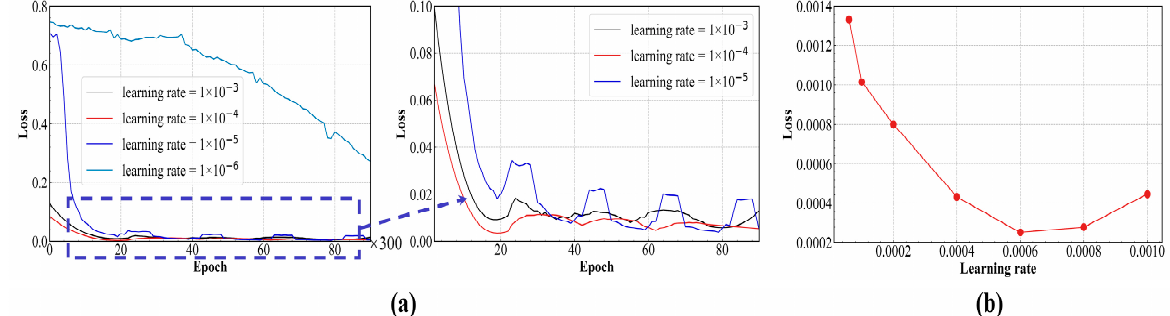
Figure 12. ( a ) Validation loss during the training; ( b ) minimum values of the validation loss with different learning rates.